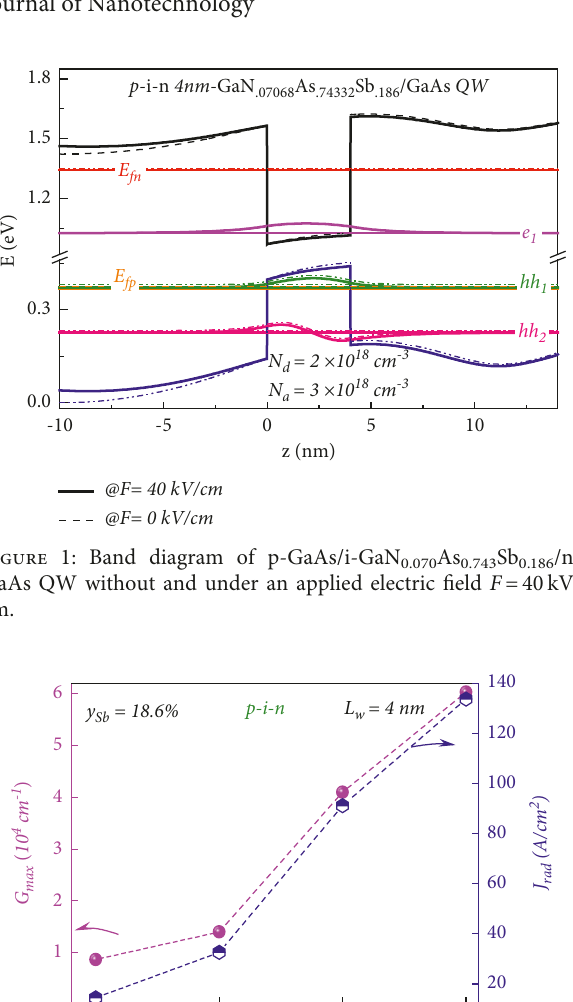
Figure 2: Optical gain and radiative current density as function of injected carriers density N inj ranging from 5 × 10 17 to 2 × 10 18 cm − 3 for p-GaAs/i-GaN 0.38y As 1–1.38y Sb y /n-GaAs QW structure. The Sb composition and well width are y Sb � 18 . 6% and L w � 4nm,